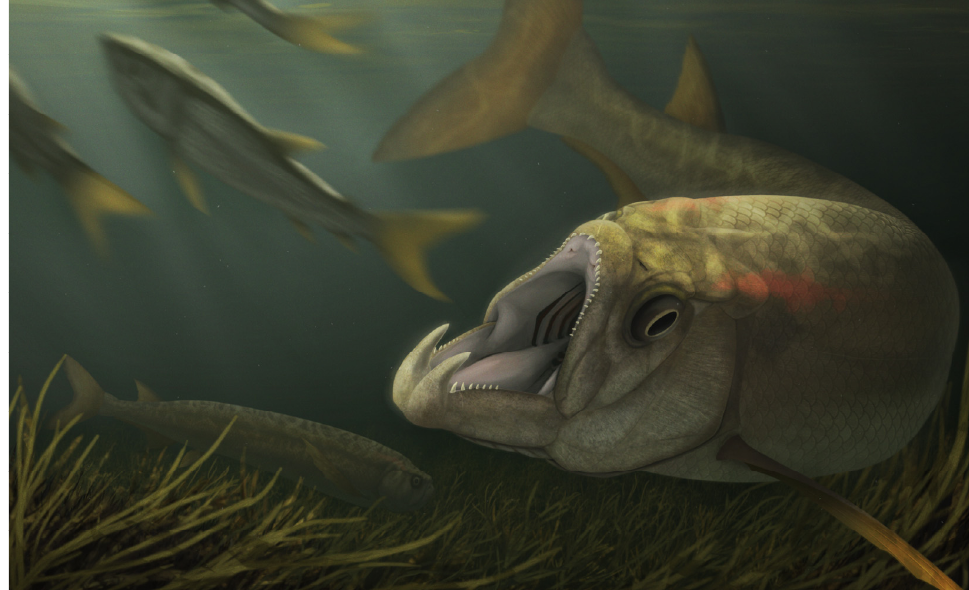
Figure 9. † Cladocynodon araripensis gen. et sp. nov. Reconstruction of lifestyle (illustration by Vitor Silva).